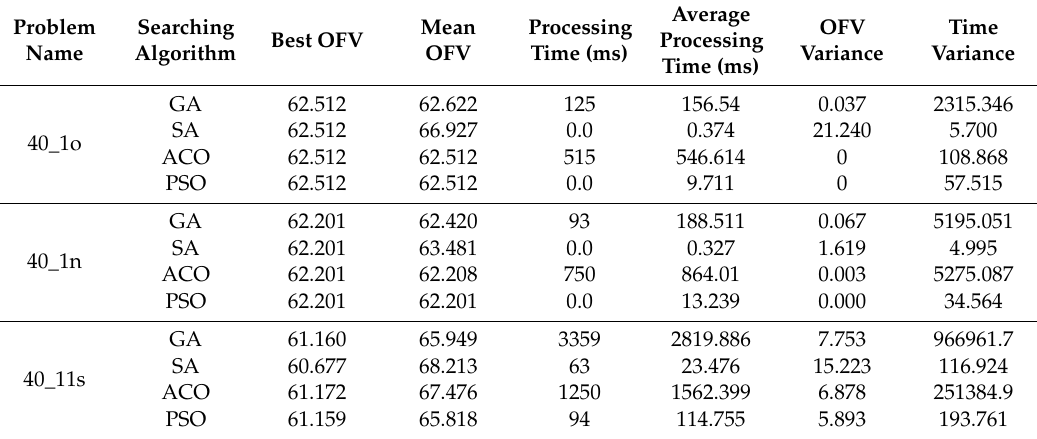
Table 14. Experimental results of the metaheuristic algorithms within 40 × 40